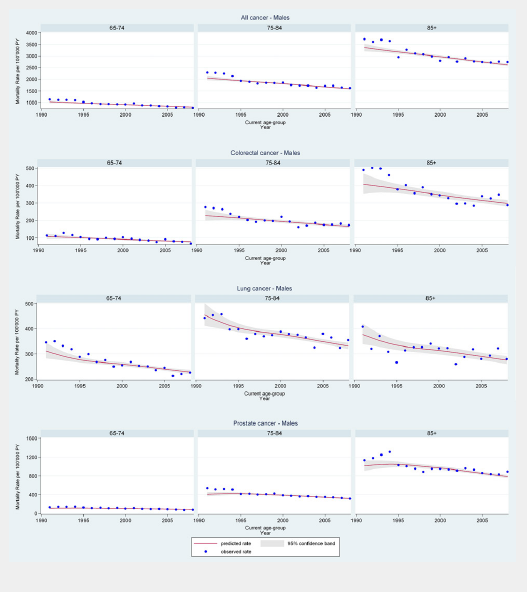
Age-specific cancer mortality from 1991 through 2008 in Swiss men ≥65 years